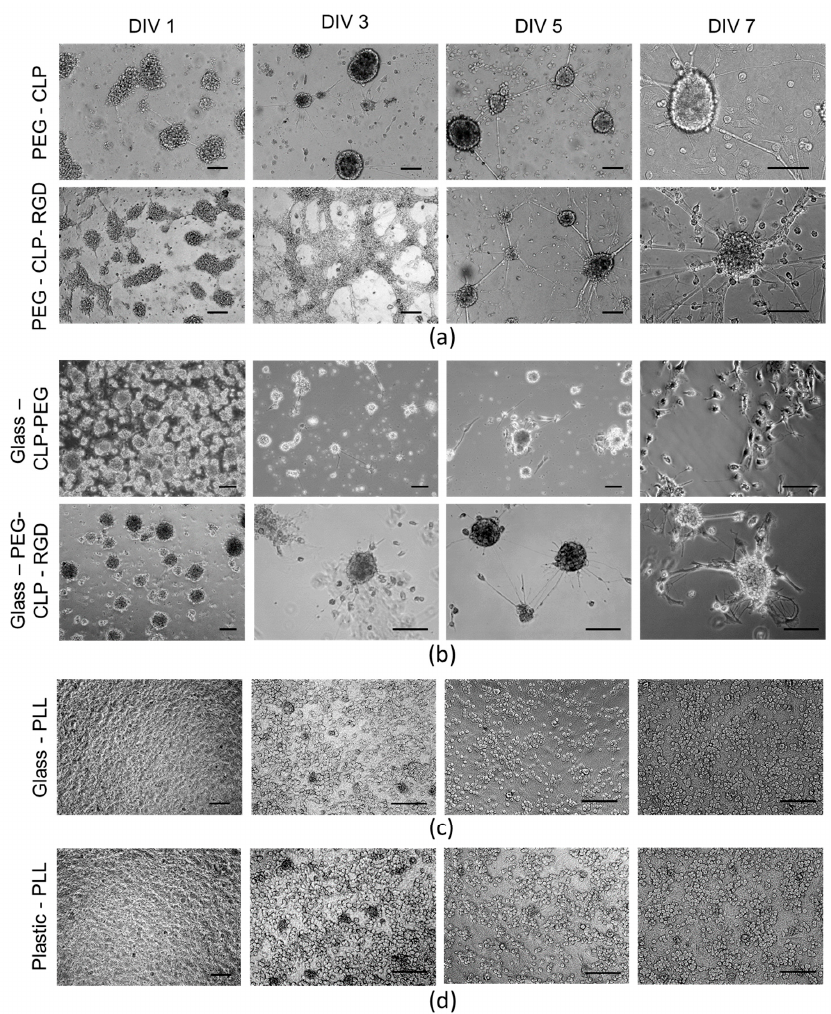
Figure 3. Phase-contrast images of alive cerebellar neuronal-glial cell cultures developing on PEG-CLP and PEG-CLP-RGD hydrogel membranes ( a ), on glass coated with PEG-CLP or PEG-CLP-RGD conjugates ( b ), on poly-L-lysine-coated glass ( c ), and on plastic ( d ). The small round cell bodies belong to granule neurons and the larger bodies belong to microglial cells. The astrocyte bodies are not visible enough in phase-contrast images. Scale bar is 100 µm.